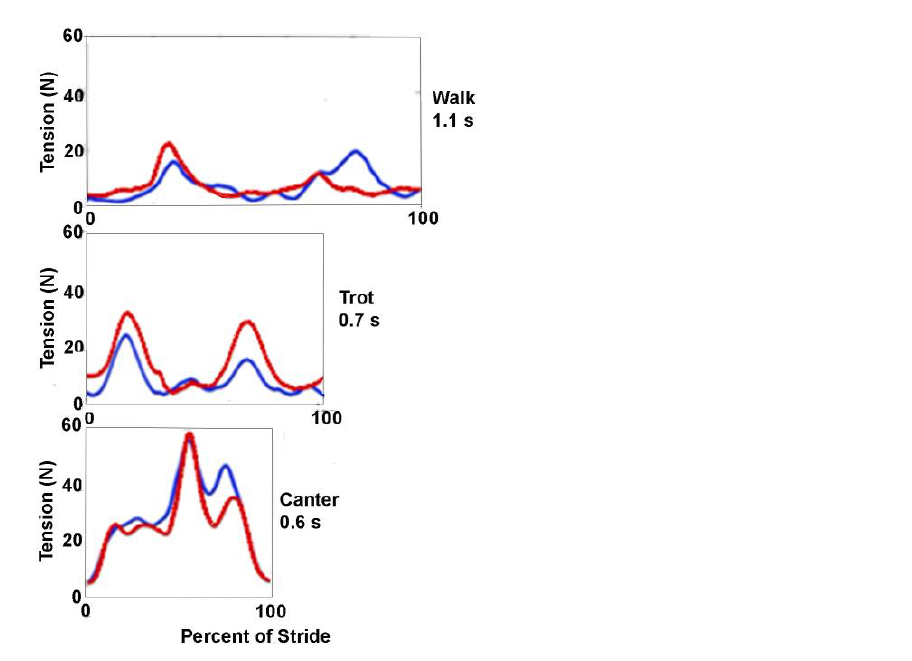
Figure 1. Rein tension traces with a rider for left rein (blue) and right rein (red) during one stride of walk (upper graph), trot (middle graph) and canter (lower graph). All graphs shown at the same tension scale on y axis. The x axis of each graph is labelled as percent of stride (i.e., time normalized) with the actual width of each graph corresponding to its stride duration which is shown top right below the name of the gait.